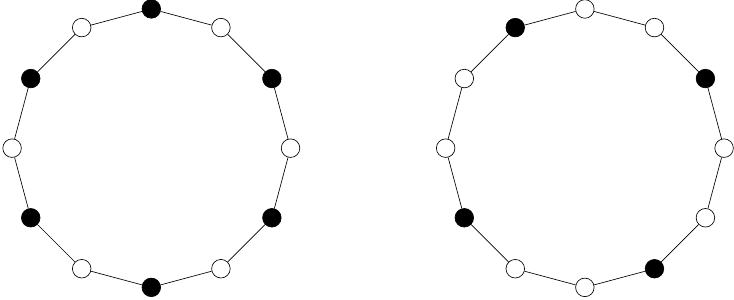
= 6 and p = 2, while on the . On the left N A A